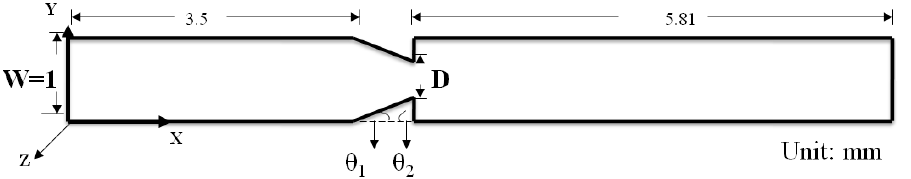
Figure 1. Schematic of the micro-channel geometry.